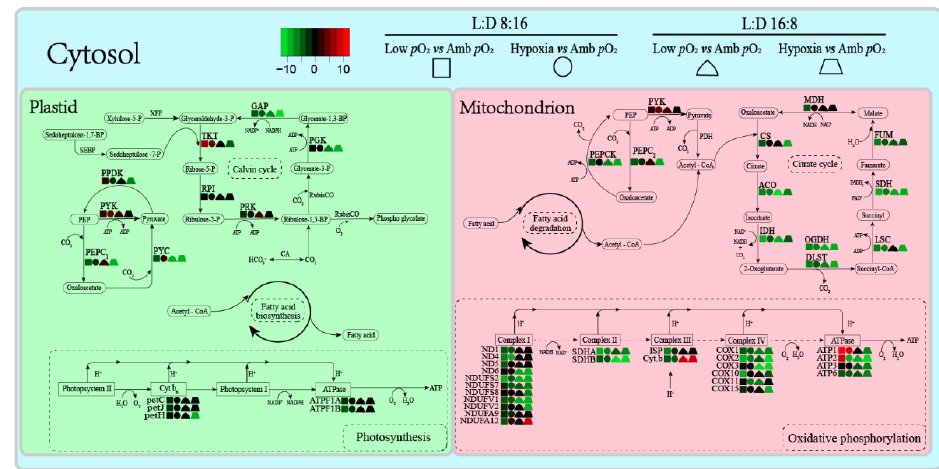
Figure 6. Schematic diagram of changed metabolic pathways of T. pseudonana under the varied p O 2 and photoperiods. Red and green colors indicate the up- and downregulation of the DEGs, respec- tively. The solid arrow indicates the direct metabolic steps in a pathway. The complete gene names are shown in Table S1.